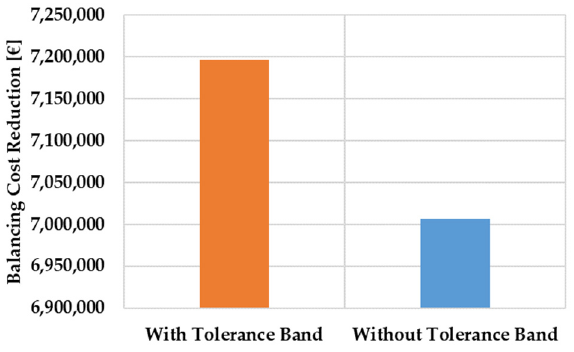
Figure 17. Balancing cost reduction when the tolerance band constraint is active.